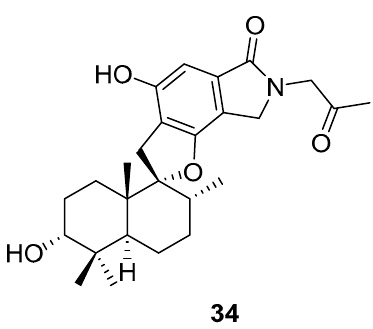
Figure 14. Structure of stachybotrin D ( 34 ).